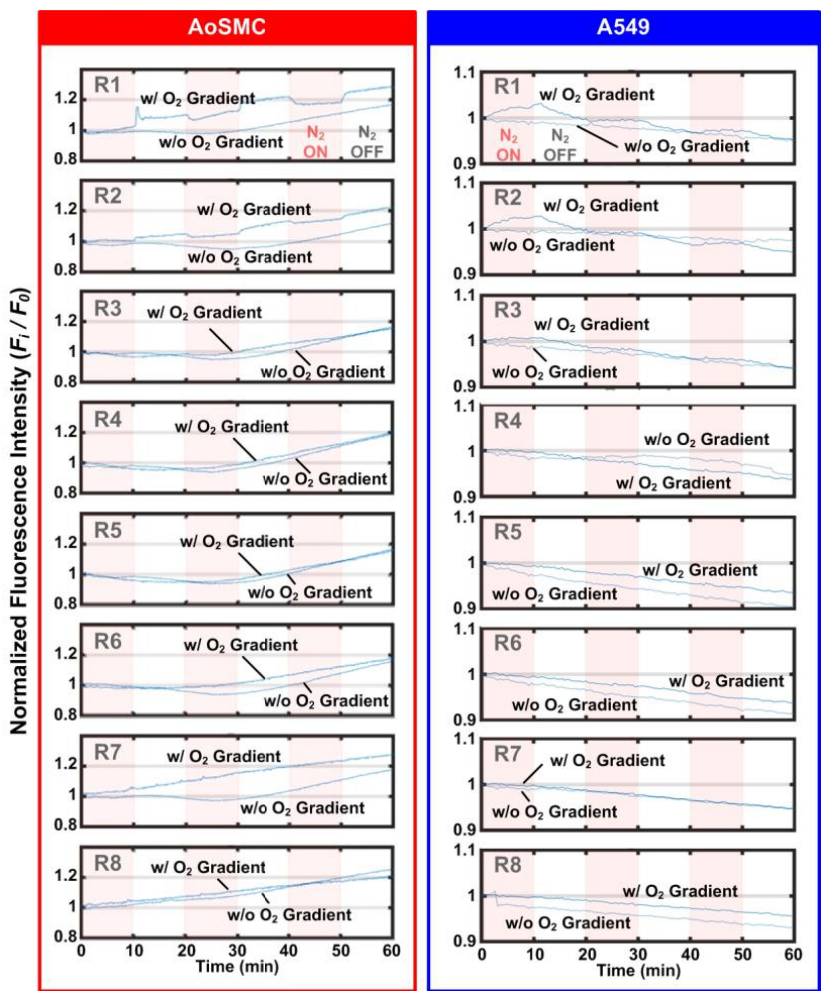
Figure 6. Temporal variation in intracellular calcium within the AoSMCs and A549 cells located in different regions (R1 to R8) based on the fluorescence intensity observation under normoxia (N 2 OFF) and oxygen gradient conditions (N 2 ON). Red background regions indicate the periods when nitrogen gas is on (N 2 ON) for the oxygen gradient generation.